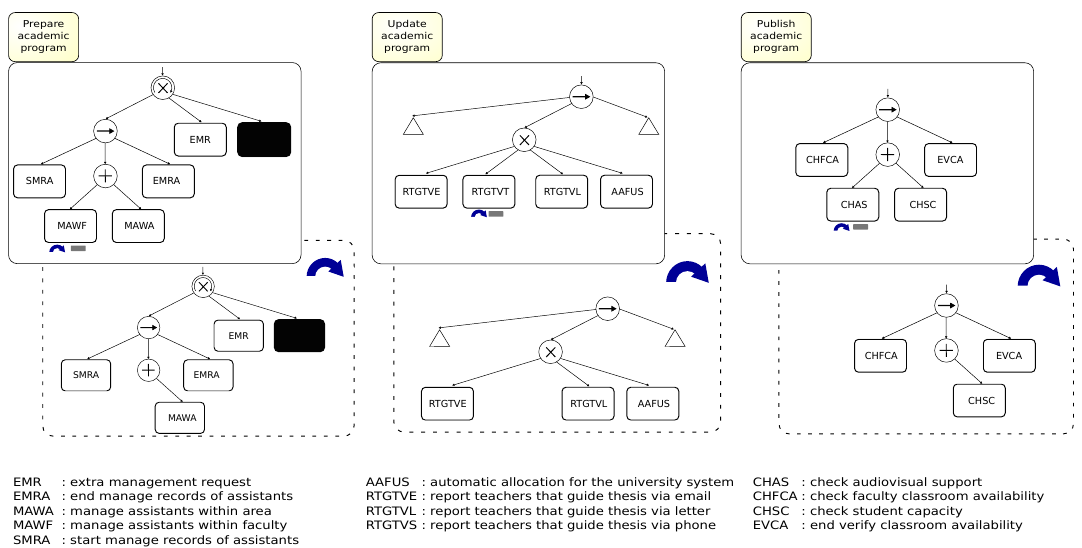
Figure 11. General idea of process model derivation for three different configurable sub-processes.